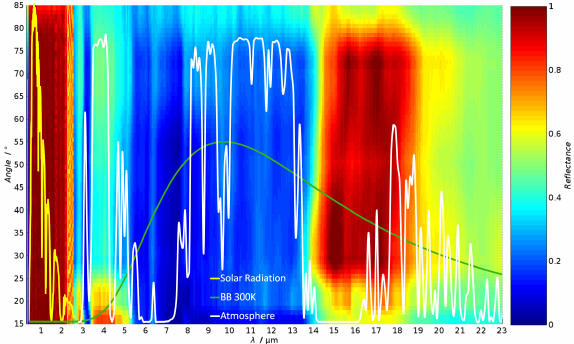
Fig. 8. A two-dimensional plot of supercool roof reflectance in wave- length and angle-of-incidence space. The x-axis spans the solar and blackbody spectral range and the y-axis ray angles to the nor- mal from 0 to 90 ∘ . Dark blue is absorptance near 100% dark red reflectance near 100%. The overlays include a plot of the incom- ing solar spectrum, the emission of a blackbody at 300 K and the atmosphere transparency.